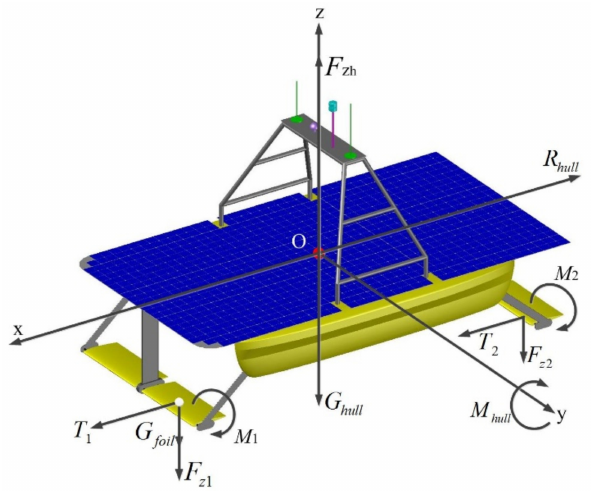
Figure 4. Force analysis of wave-driven